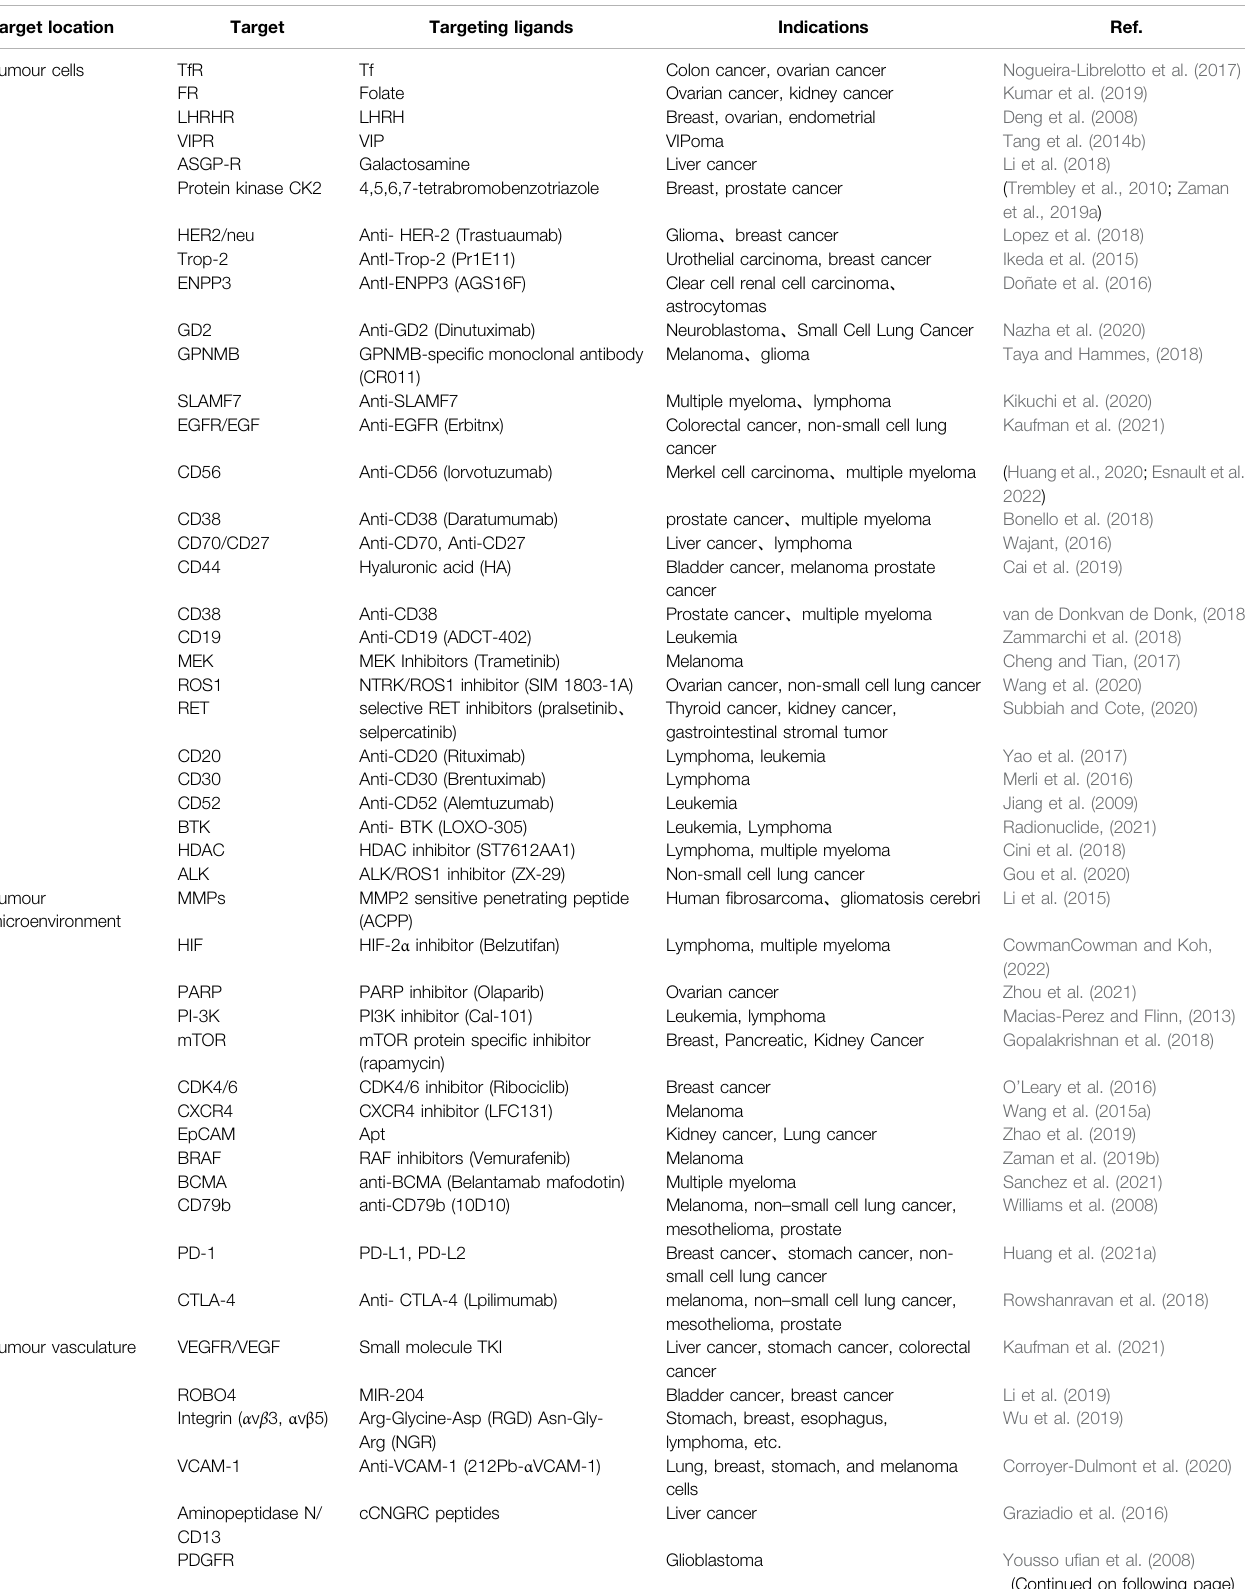
TABLE 1 | Targets and targeting agents in tumour cells, tumour microenvironment, and vasculature. Target